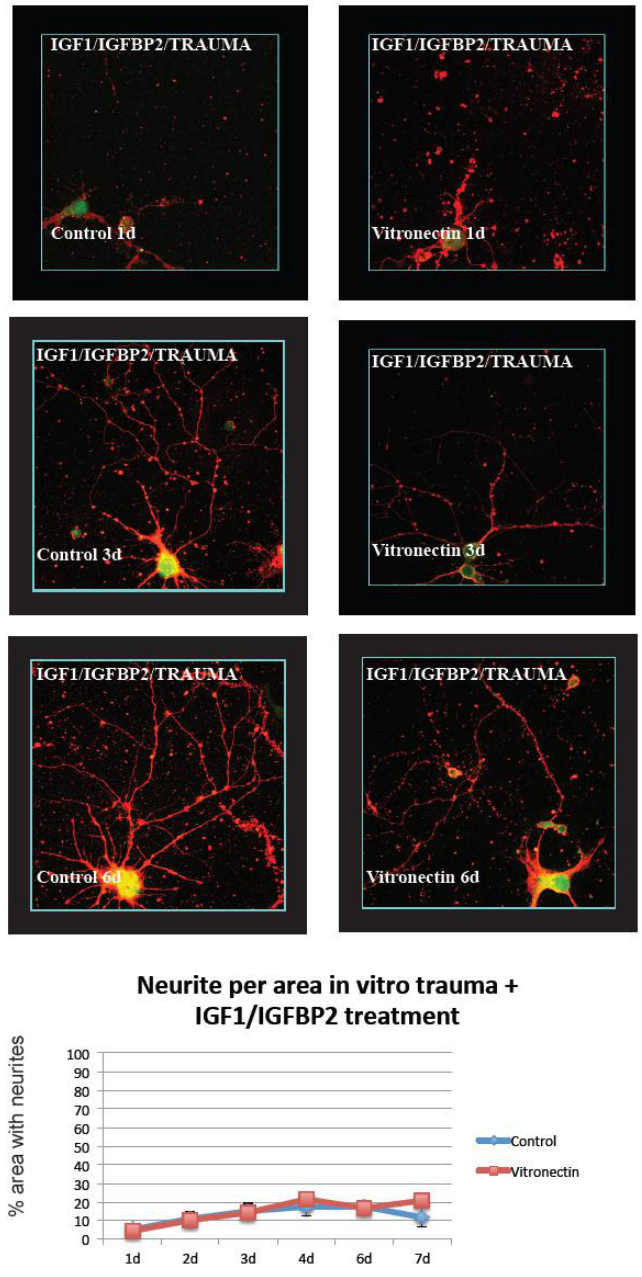
Figure 5. After in vitro trauma and treatment with IGF-1/IGFBP-2, hippocampal neurons neurite extension was calculated at the border between viable cells and the central area of injury. No difference in neurite extensions was shown on vitronectin compared to the standard coating, and a decrease in neurite density was shown compared to neurons cultured without IGF-1/IGFBP-2 treatment ( n = 6 (6 wells per time point and treatment), two-way ANOVA with Bonferroni post hoc test, p < 0.05) (red = beta III tubulin, green/yellow =